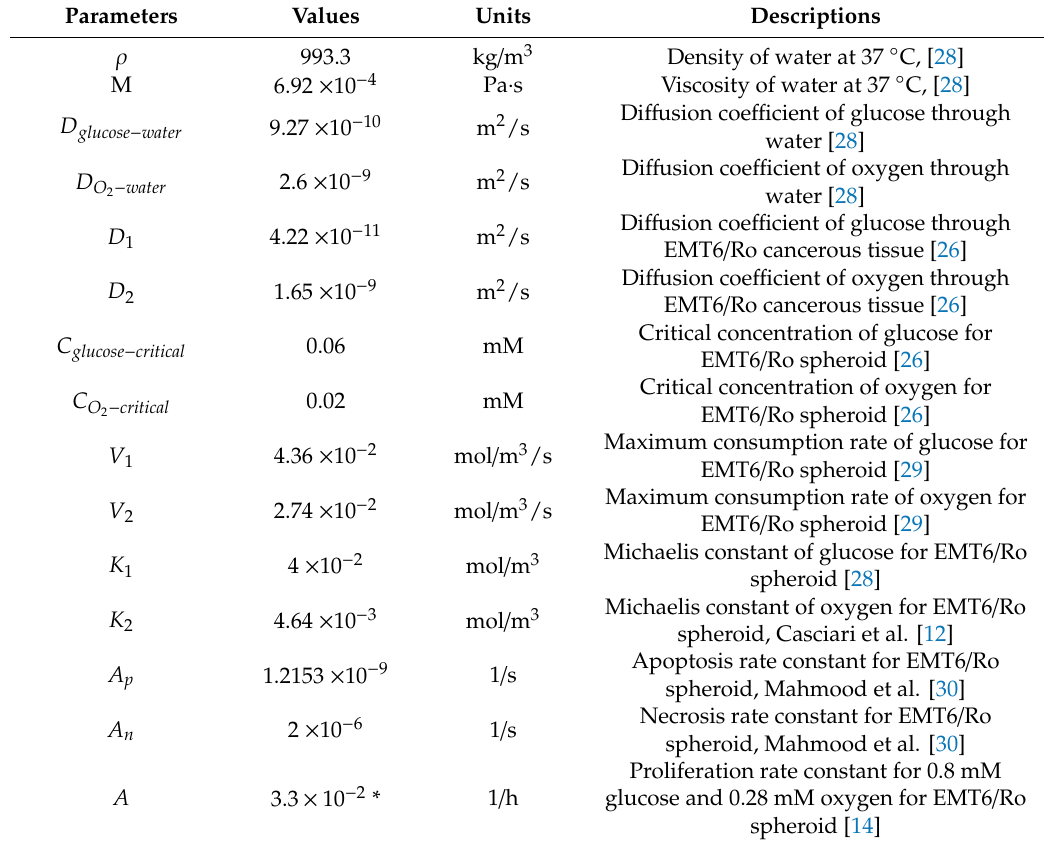
Table 1. The values of the parameters used in the proposed model.